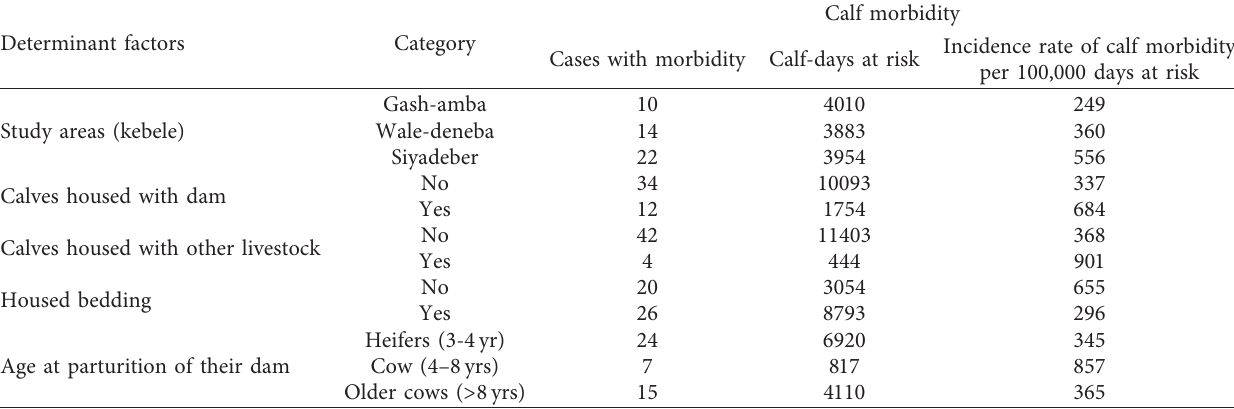
Table 6: Incidence of calf morbidity among the identified predictors of calf morbidity at Siyadeber and Wayu District, North Shawa, Amhara region,